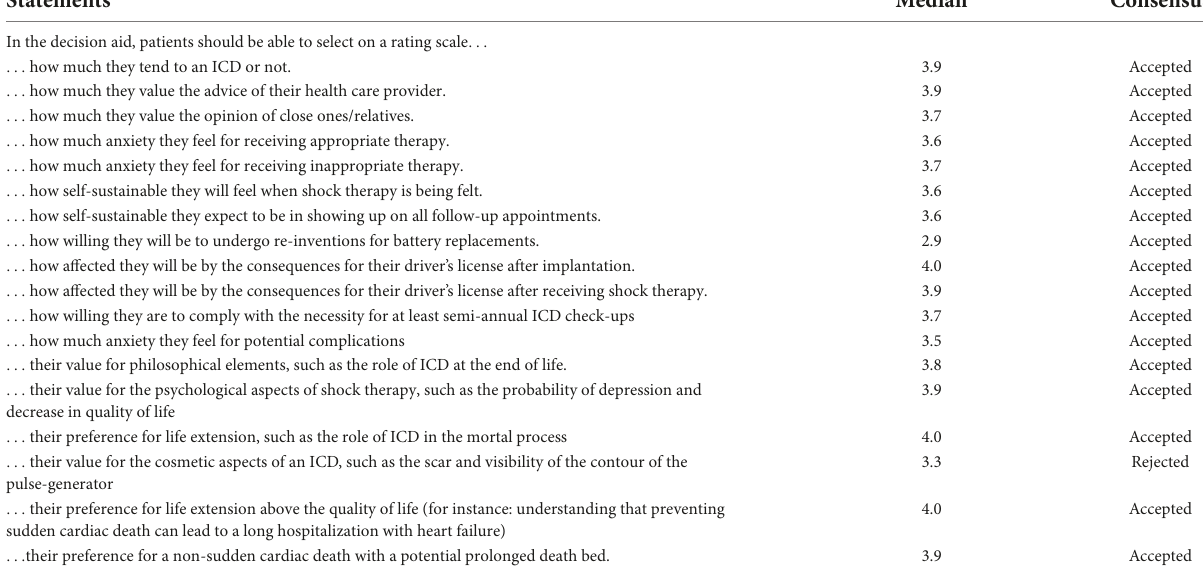
TABLE 3C Statements in Delphi round 1 on items to be included in rating scales for patients.